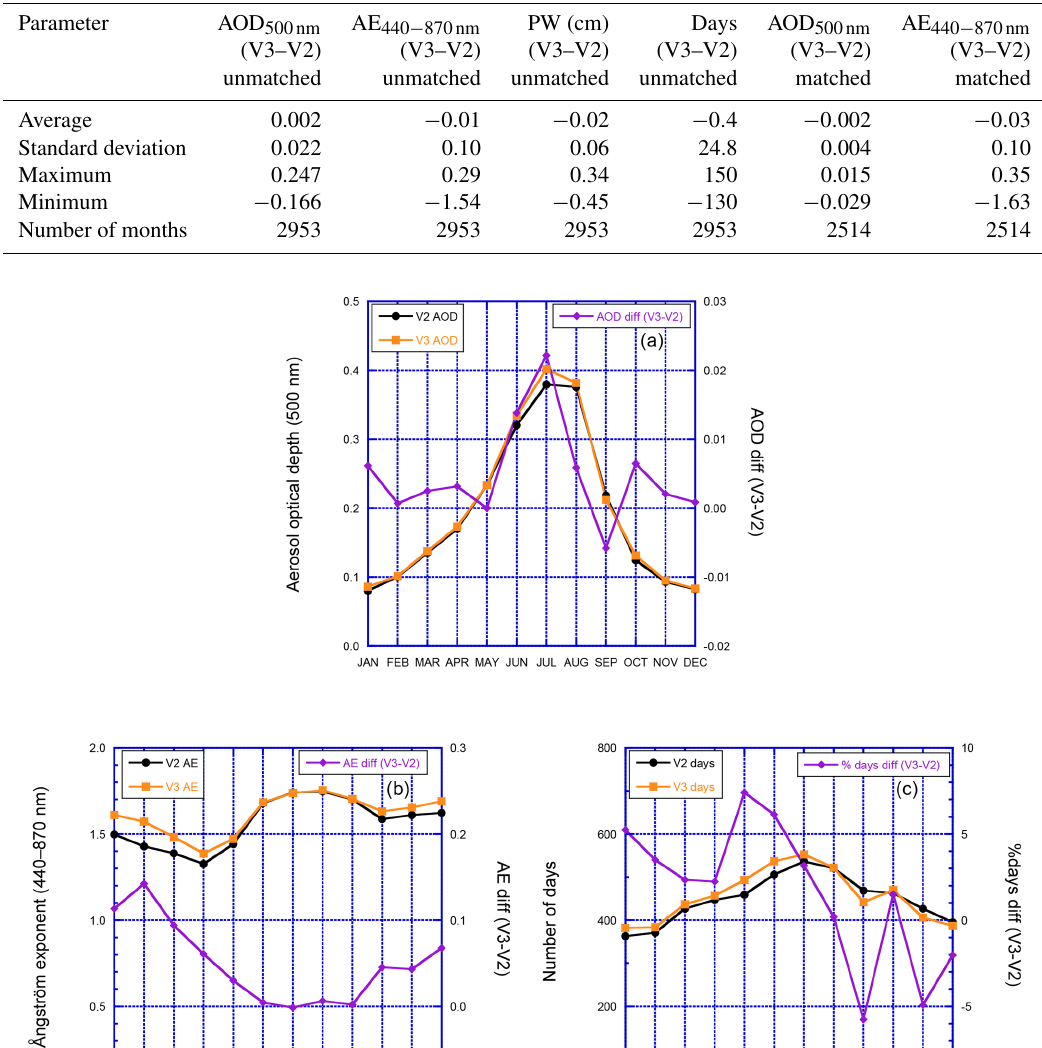
Table 5. Statistics corresponding to Figs. 21 and 22 for AOD interpolated to 500nm, Ångström exponent at 440–870nm, precipitable water (cm), and the number of days. Version 3 Level 2.0 and Version 2 Level 2.0 data are compared for the same multiyear monthly averages when sites have a total of more than 1000 days for all months and more than 30 days in each month. Data represented as “matched” indicates